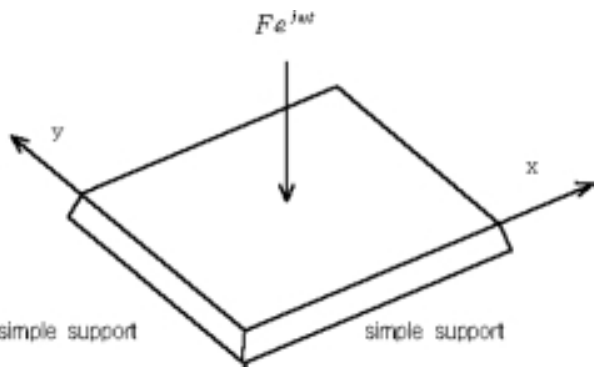
Fig. 1. The orthotropic plate response problem, displacement solution.